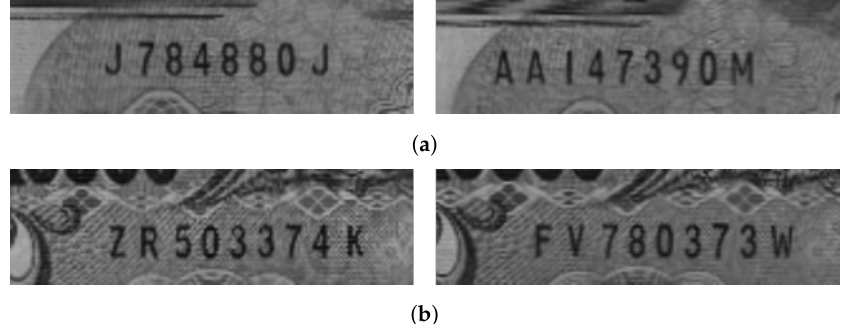
Figure 9. Typical images from set B. ( a ) 2000 Yen ( b ) 10,000